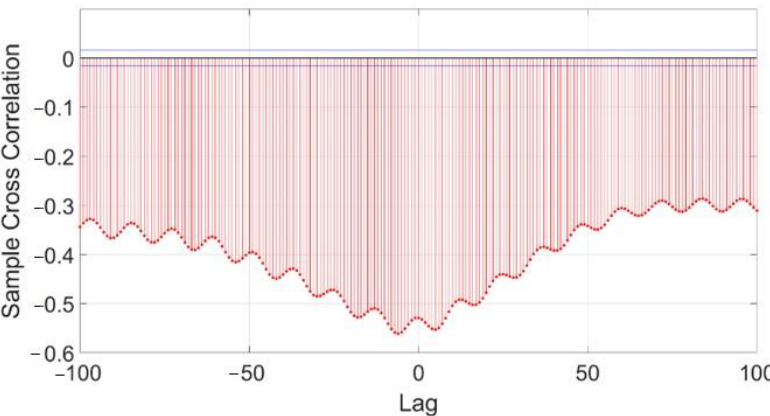
Figure 7. The cross-correlation functions between air pressure and sea level time series.